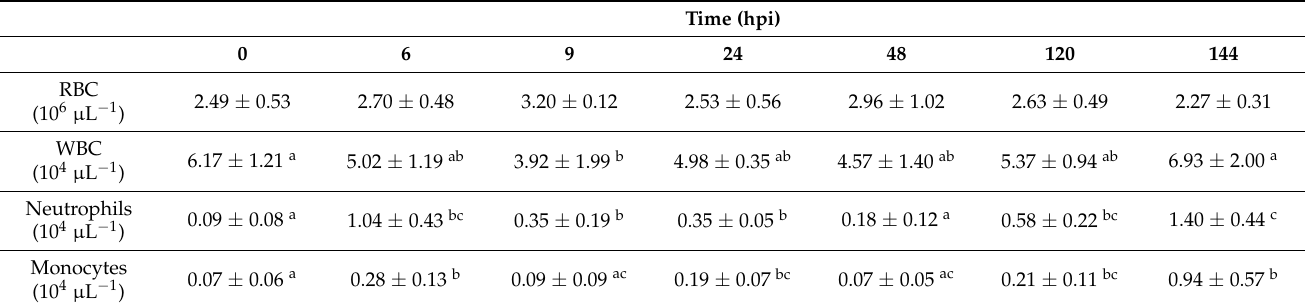
Table 1. Hematological parameters of European seabass ( Dicentrarchus labrax ) infected with RGNNV at different sampling times